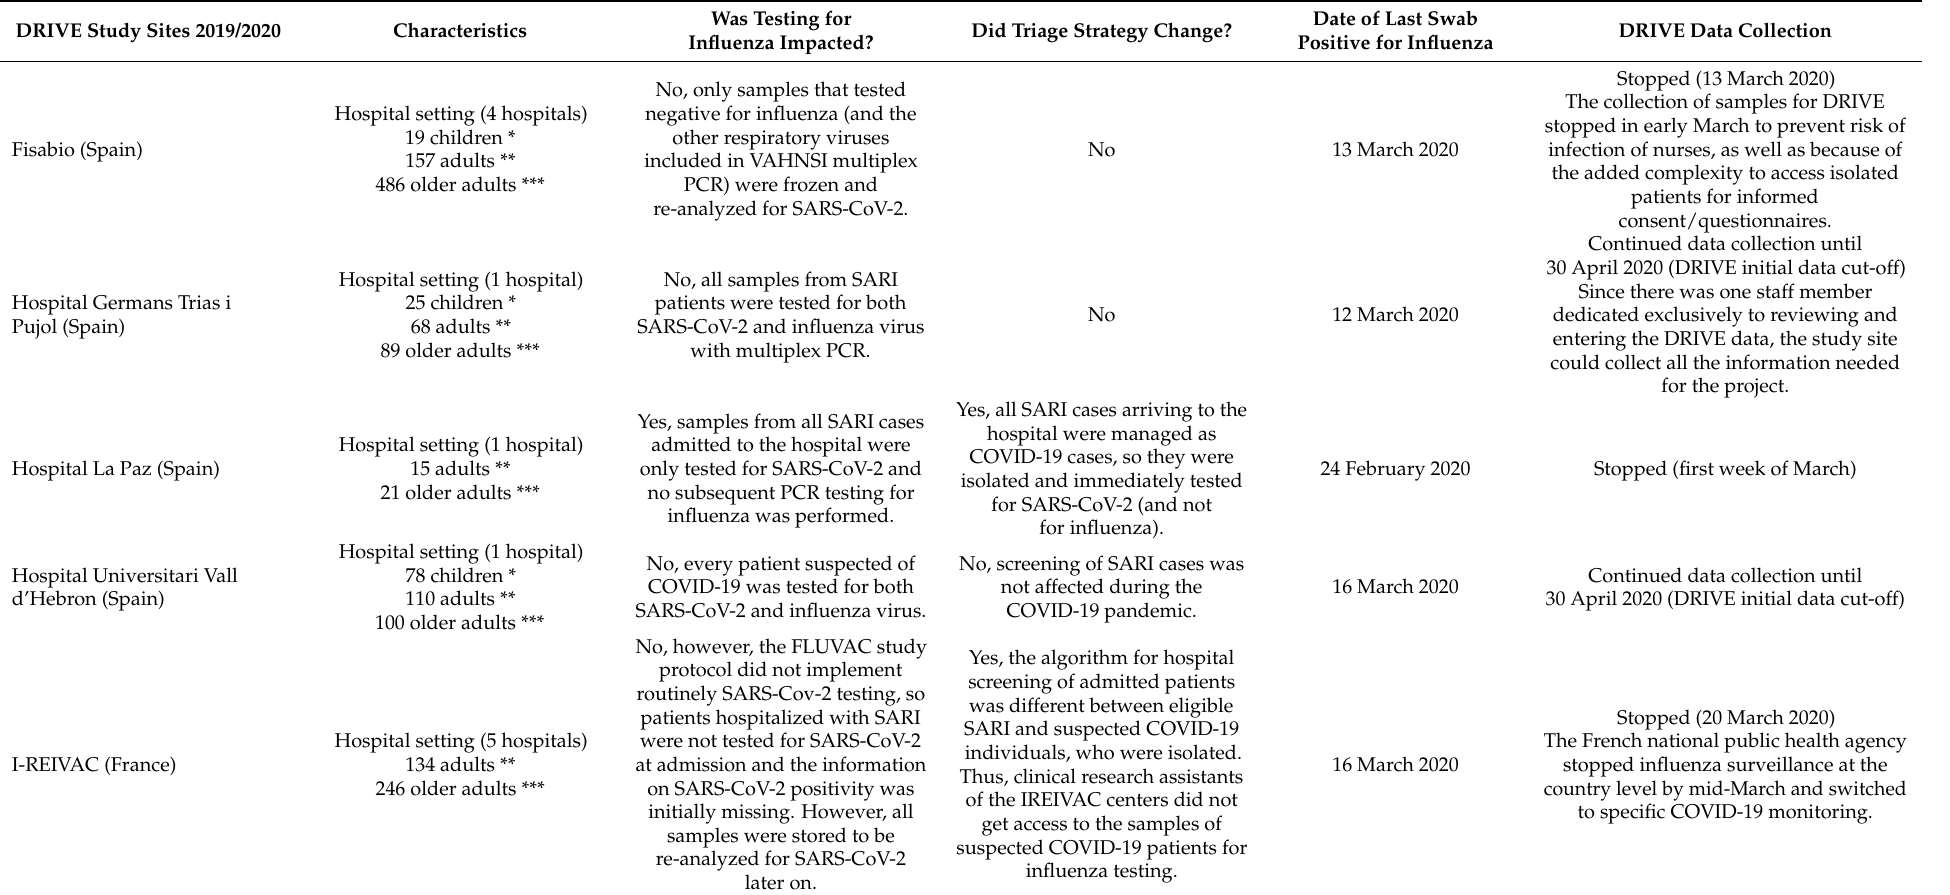
Table 2. DRIVE study sites: COVID-19 impact on data collection, triage and testing strategies during the 2019/20 season. * Children: 6 months to 17 years old recruited in 2019/2020 season; ** Adults: 17 to 65 years old recruited in 2019/2020 season; *** Older adults: >65 years old recruited in 2019/2020